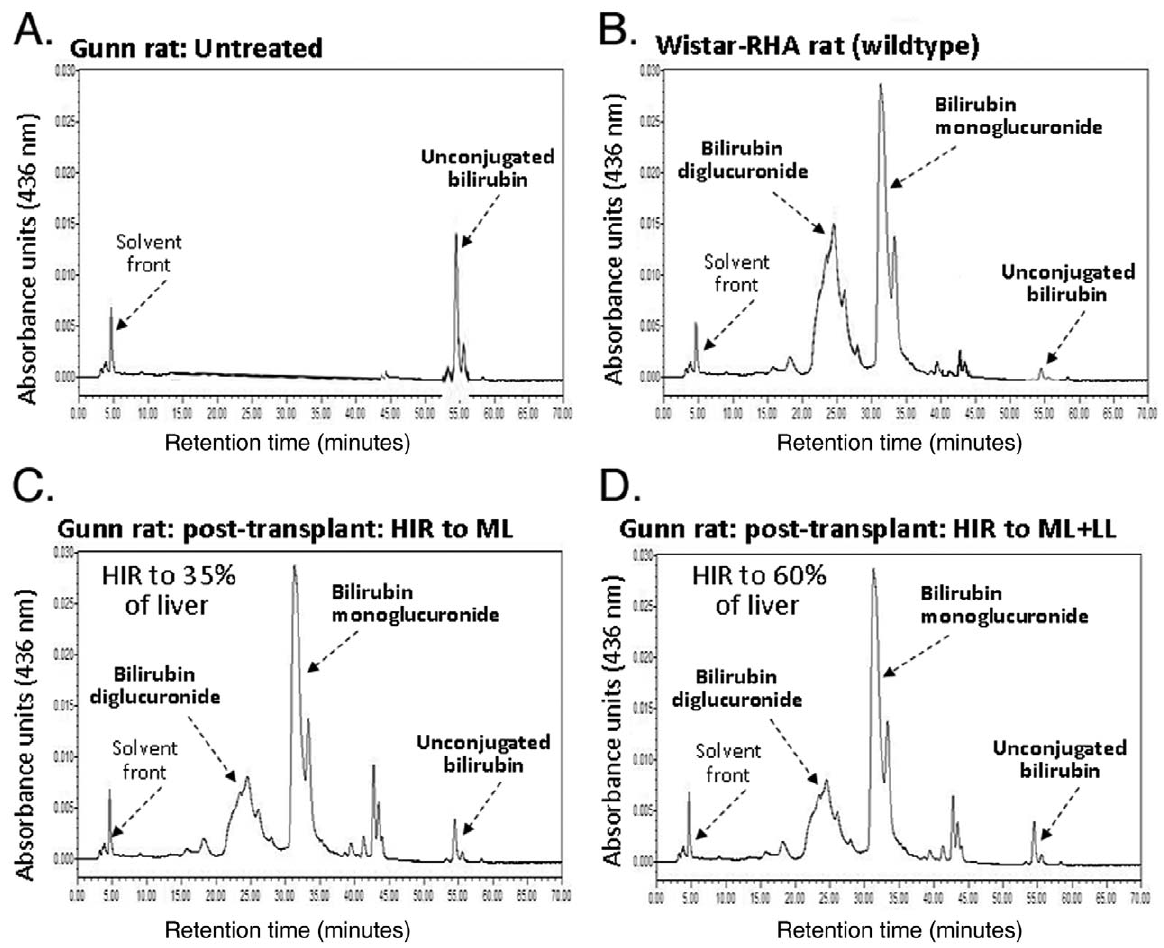
Figure 3. HPLC profile of bilirubin species excreted in bile. (A) The bile of untreated Gunn rats contained some unconjugated bilirubin, but no bilirubin glucuronides. (B) Bile of the wildtype Wistar-RHA donors contained predominantly bilirubin diglucuronide and monoglucuronide and a very small amount of unconjugated bilirubin. (C) Three months after hepatocyte transplantation following HIR to 1/3 of liver, the pigment profile of bile in transplant-recipient Gunn rats became similar to that of the normal Wistar rats, except that there was still a significant amount of unconjugated bilirubin in the bile. (D) Three months after hepatocyte transplantation following HIR to 2/3 of liver, the pigment profile of bile in transplant-recipient Gunn rats became similar to that of Gunn rats received HIR to 1/3 of